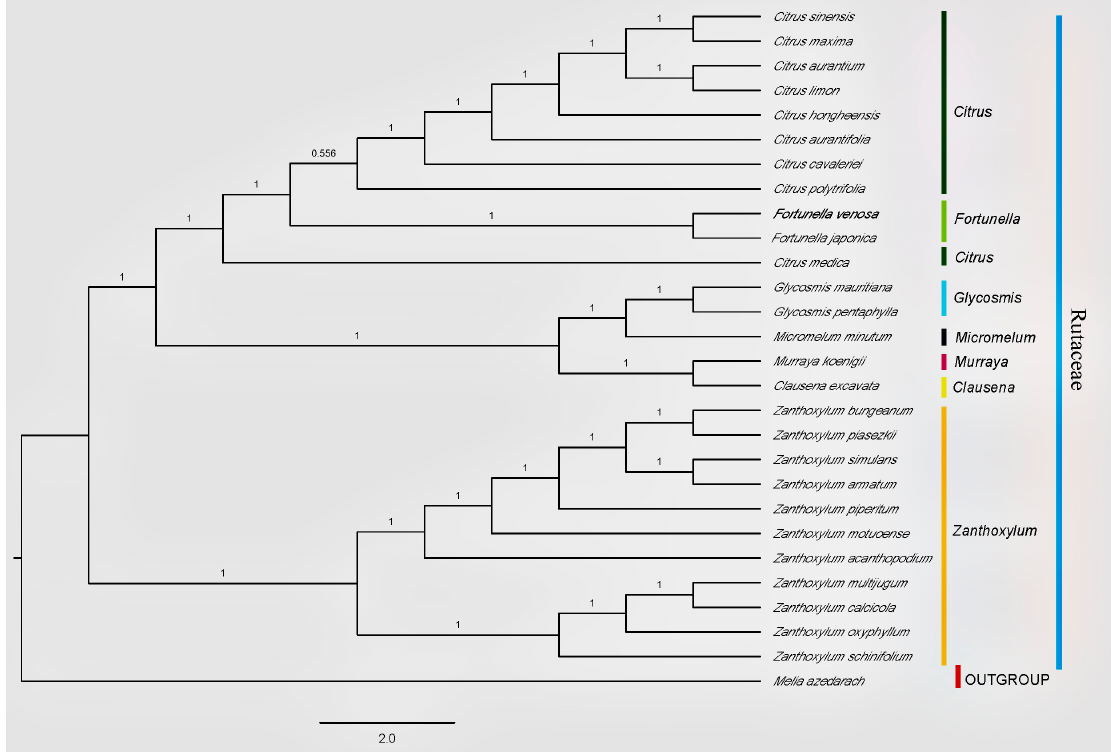
Figure 10. Phylogenetic trees based on BI of Rutaceae species based on whole chloroplast genome sequences, with one species from family Melia used as outgroup. The Bayesian inference (BI) tree with posterior probabilities values on the